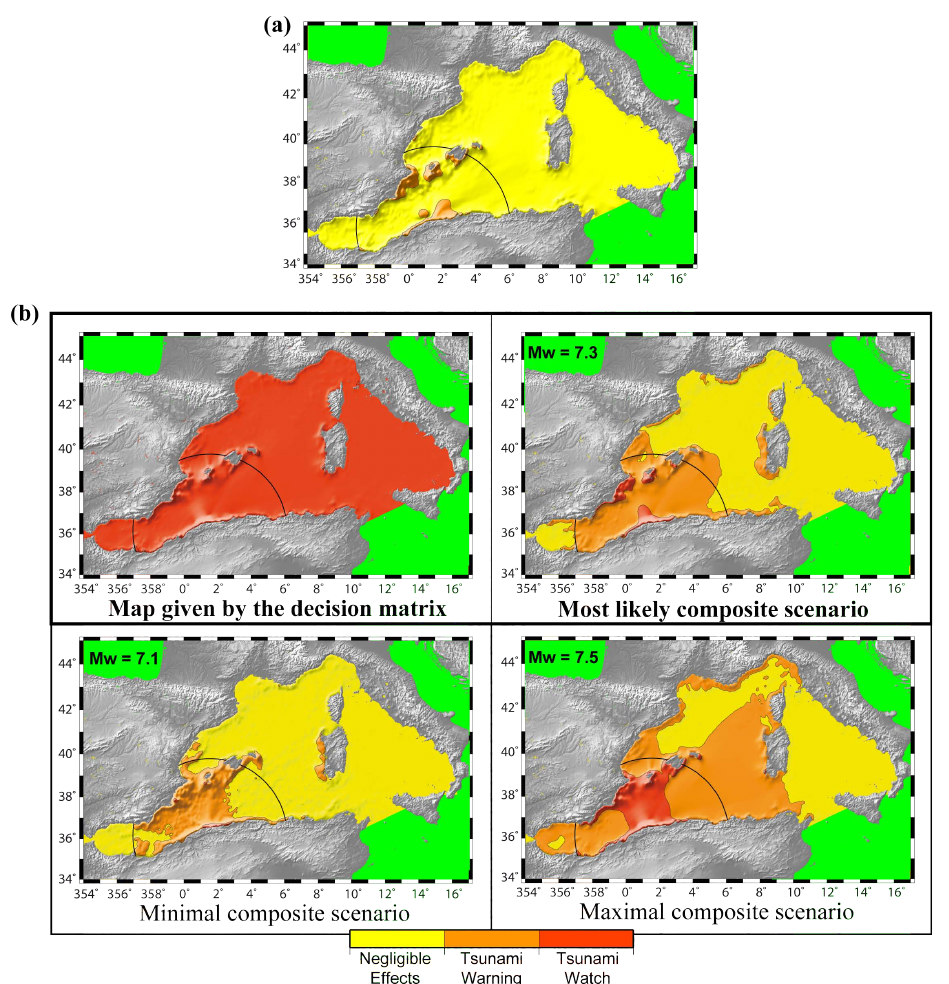
Fig. 13. (a) Warning map resulting from “on the fly” tsunami modeling using the source parameters of Roger et al. (2007) for the 1980 El Asnam earthquake ( M w = 7 . 3, Algeria). (b) Result of the composite scenarios calculation process: final representation destined for the French authorities using the test case of the 1980 El Asnam earthquake. Black circle: 400km radius area around the epicenter (decision matrix